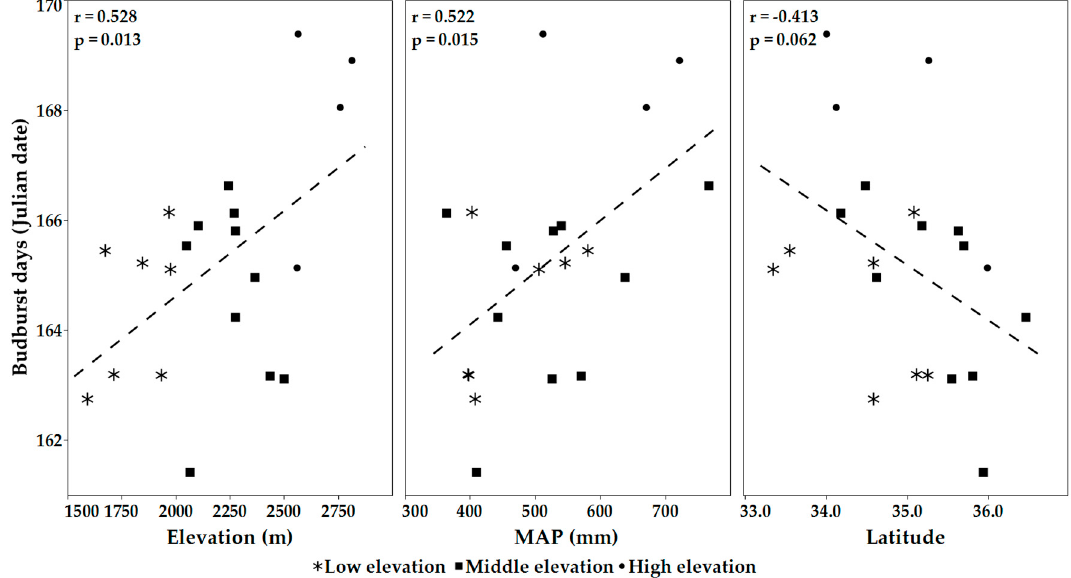
Figure 2. Relationships between provenance mean budburst date and elevation, mean annual precipitation (MAP), and latitude ( n = 21). Elevation group is shown by different symbols.